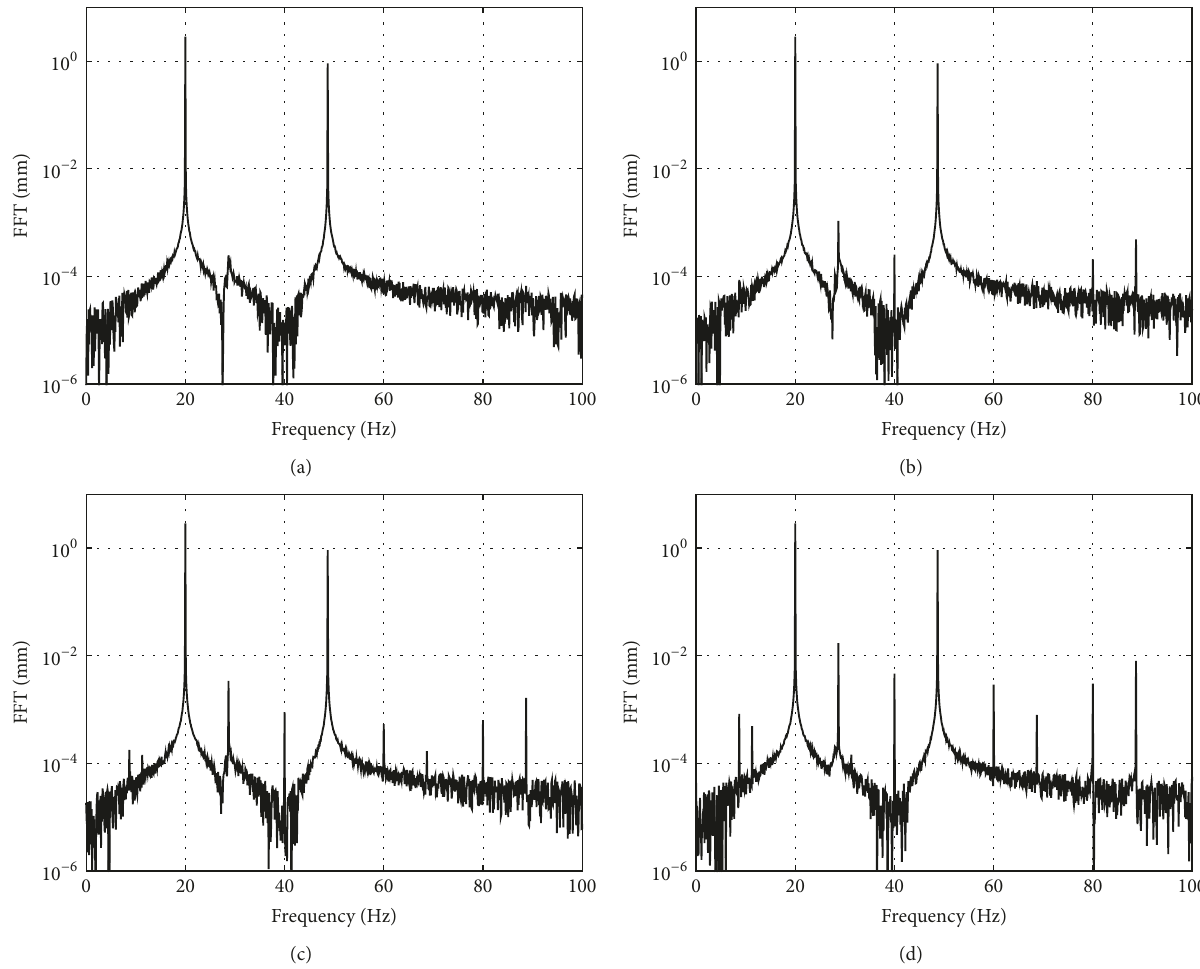
Figure 7: FFT of the system vibration responses at node #8 as excited by the diagnostic frequency of 48.7 Hz at node #4 (rotating speed of 1200 rpm and SNR = 1000): (a) 1% crack depth; (b) 3% crack depth; (c) 5% crack depth; (d) 10% crack